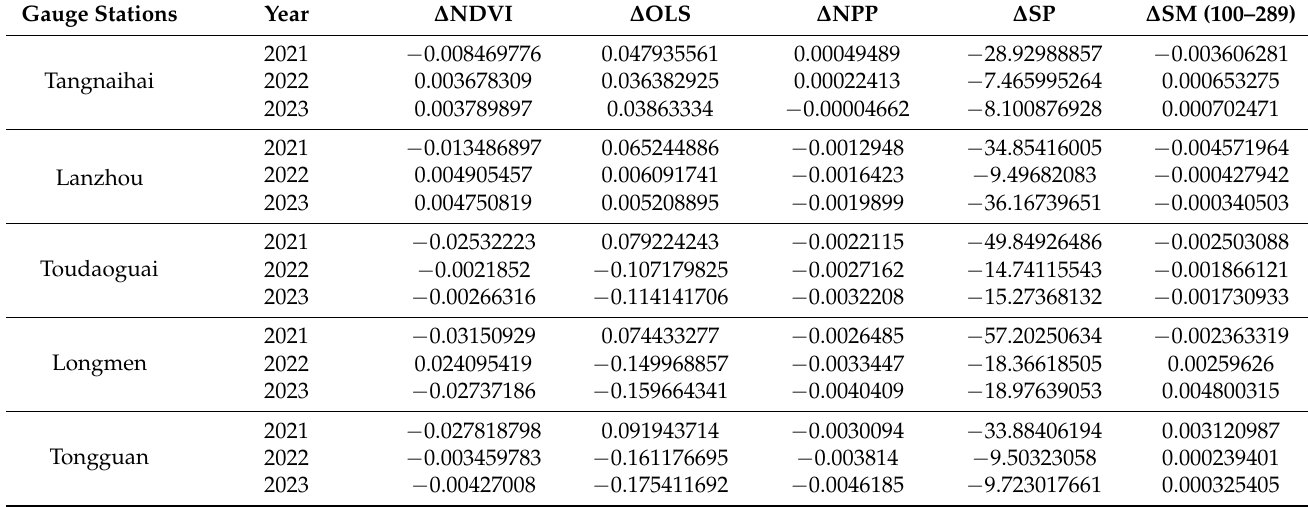
Table 5. Predicted values for the five driving factors (2021–2023). The definitions of the abbreviated variables can be found in Table 1. The prefix ‘ ∆ ’ indicates the amount of interannual variation in the